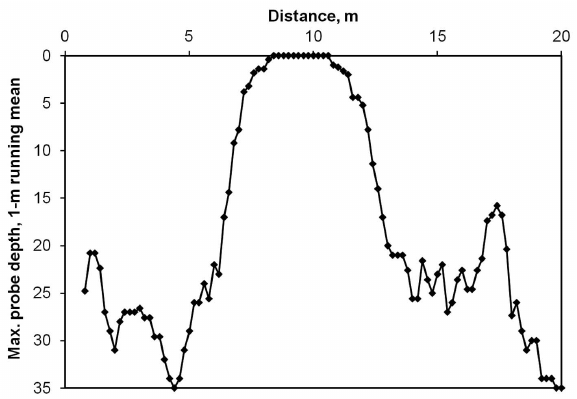
Fig. 5. – The census count of Octopus tetricus individuals occupy- ing the shell bed and nearby diver-placed objects (Godfrey-Smith and Lawrence 2012) (solid line with square markers); and the cen- sus count for the shell bed only (dashed line with round markers). See Methods for census details.